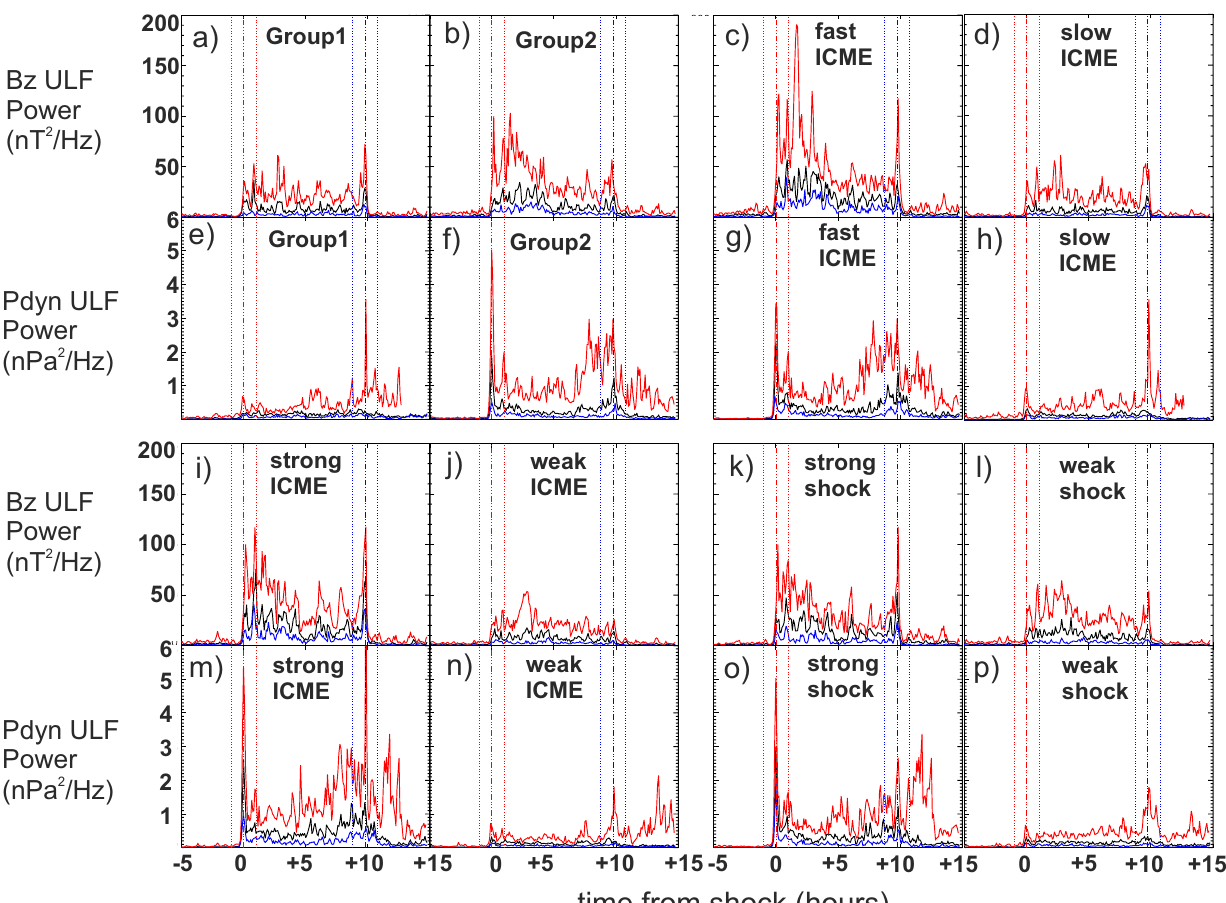
Fig. 4. B Z and P dyn ULF power separated into different categories (see Table 2).